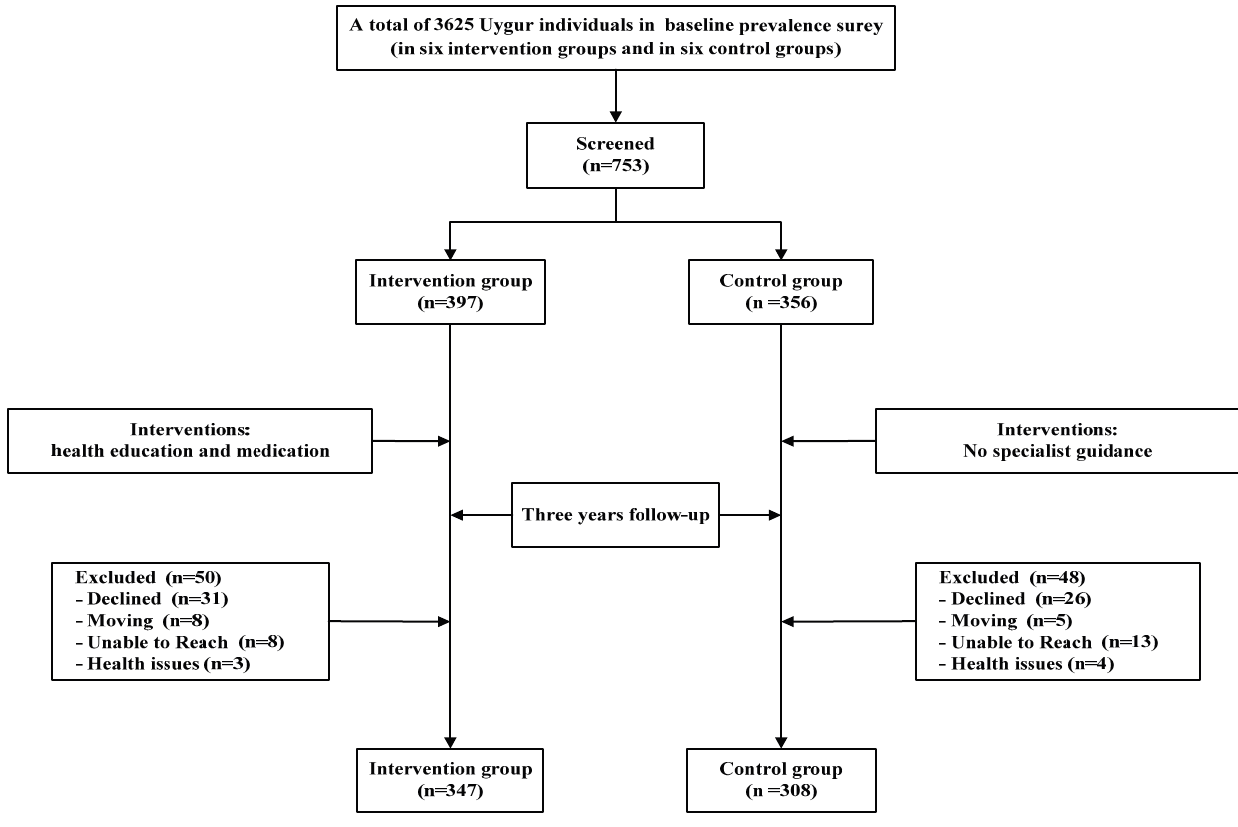
Figure 1. Patient selection and